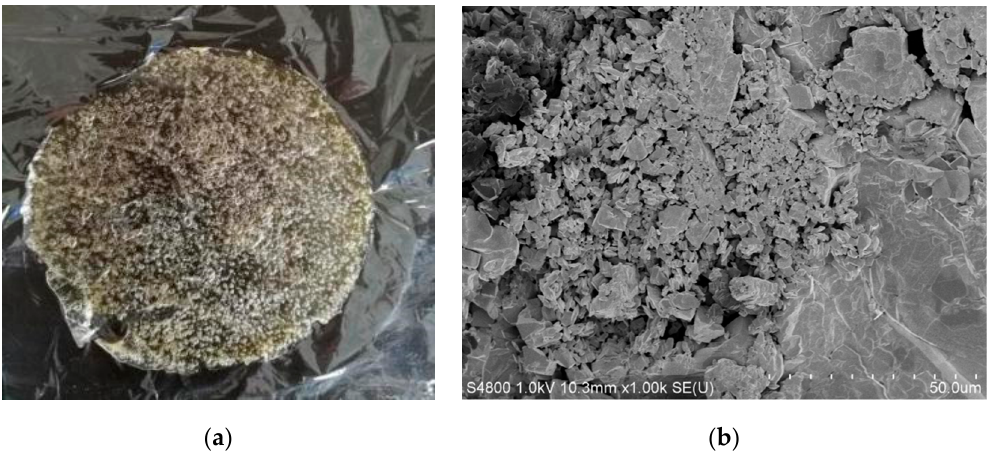
Figure 1. Appearances of the composite porous film 1# of carboxymethyl chitosan/alginate/tranexamic acid: ( a ) optical view, showing a porous structure and ( b ) scanning electron microscopy (SEM) micrographs, showing the loaded tranexamic acid.